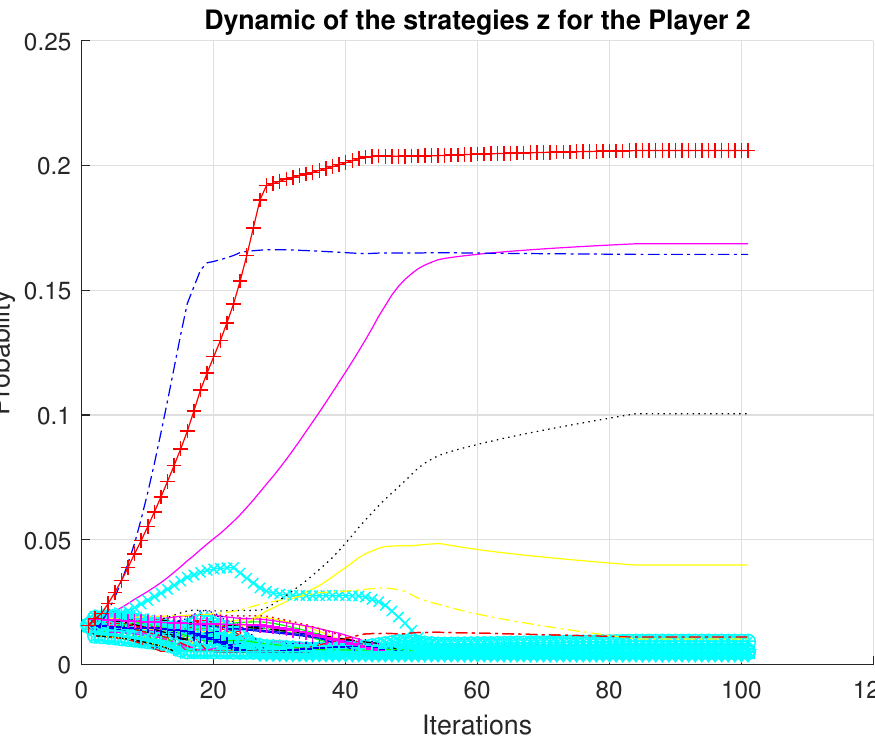
Figure 2. Convergence of strategies z imkk (cid:48) for player 2.